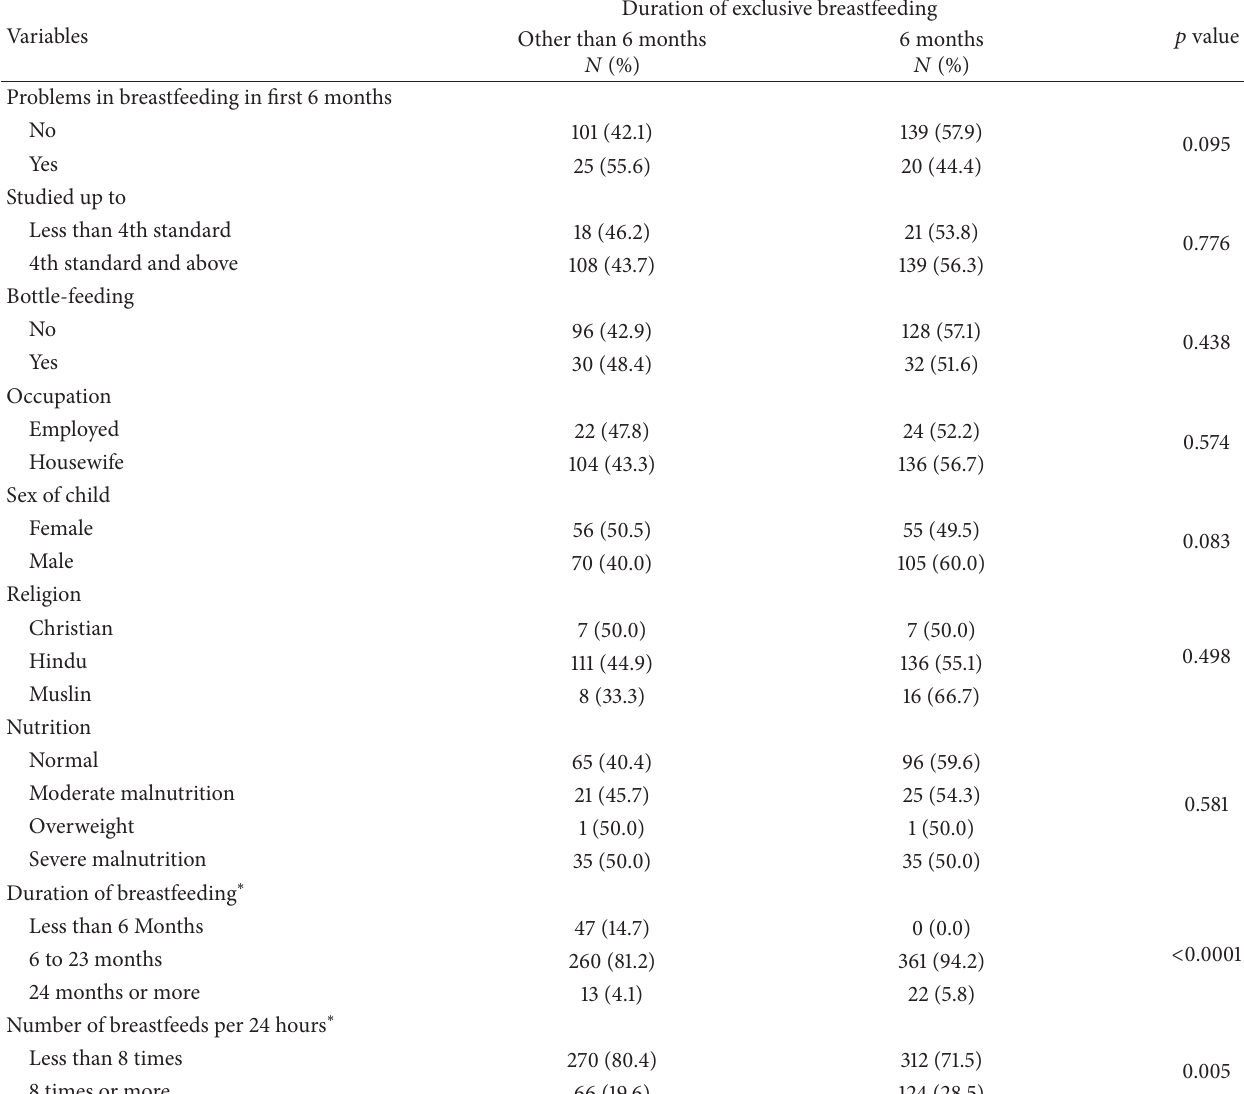
Table 3: Univariate analysis for exclusive breastfeeding in children more than 2